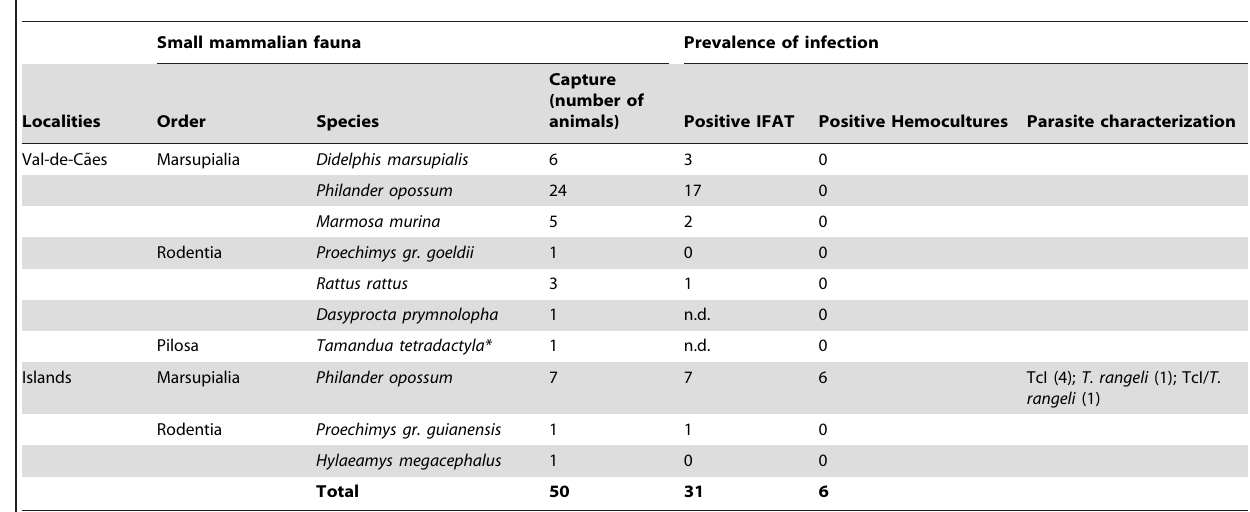
Table 1. Capture and prevalence of infection by Trypanosoma cruzi of the small mammalian fauna examined in Val-de-Ca˜es, and islands Combu, Murutucu and Pato, Bele´m